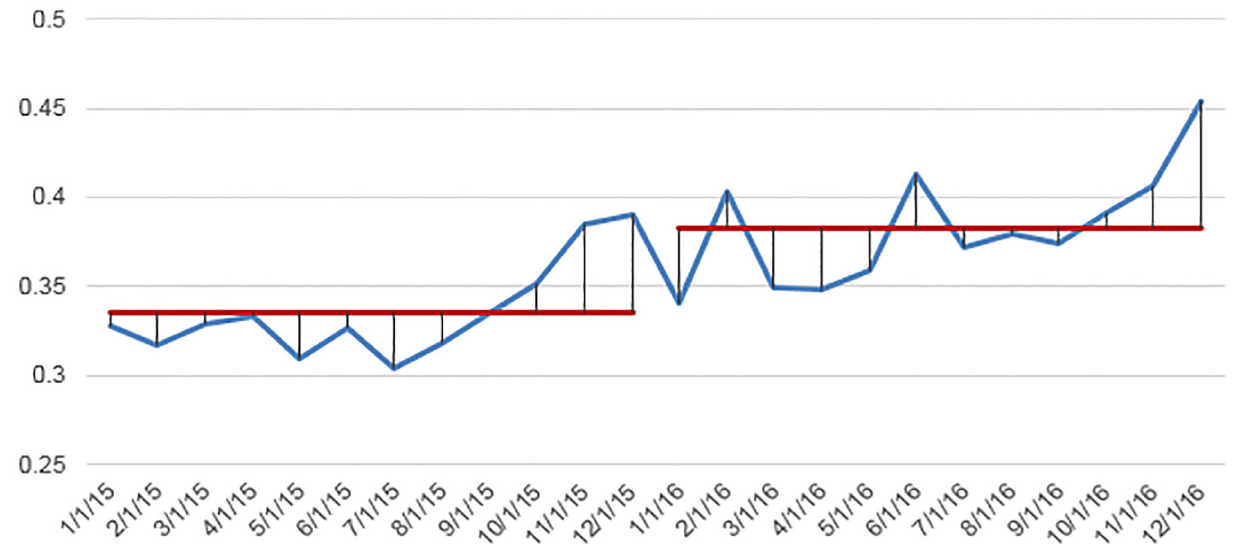
Figure 2. Emergency department antibiotics ordered per patient visit before (1/2015 -12/2015) and after (1/2016 -12/2016) sepsis protocol implementation.